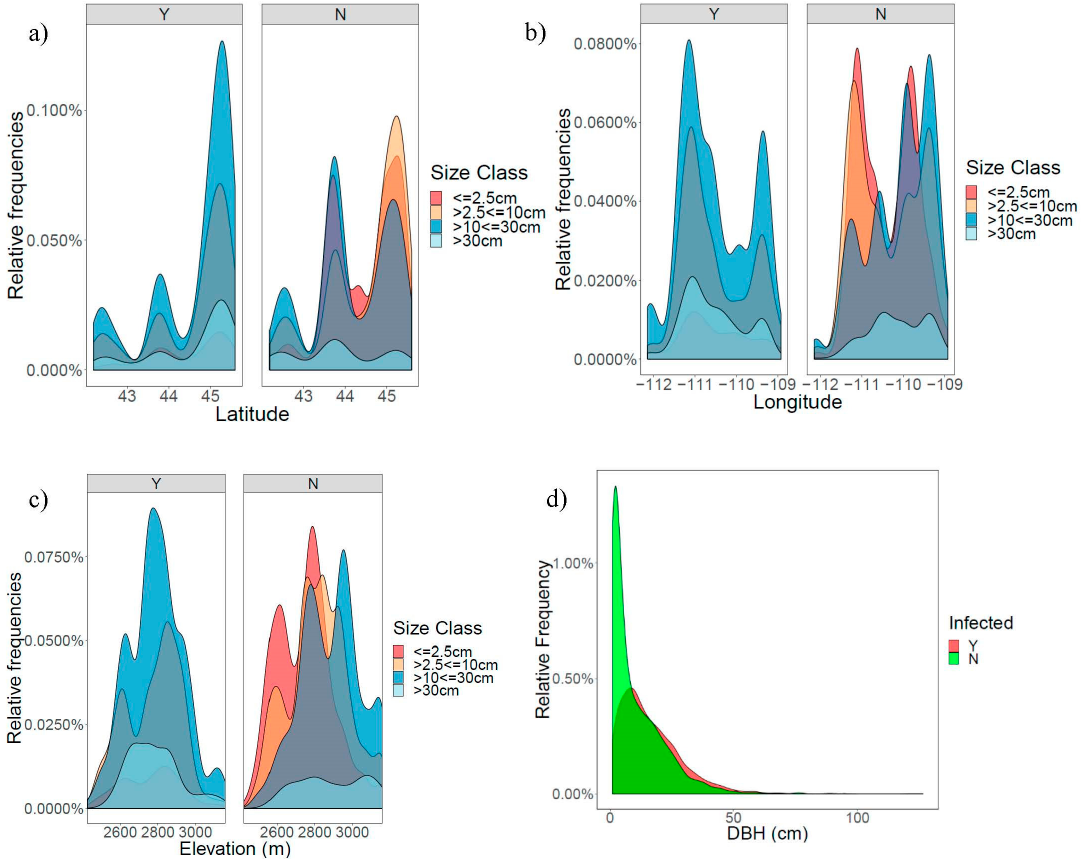
Figure 2. Proportion of white pine blister rust infected (Y) and uninfected (N) trees by ( a ) latitude, ( b ) longitude, ( c ) elevation, and ( d ) the proportion of infected and uninfected trees by DBH (cm).